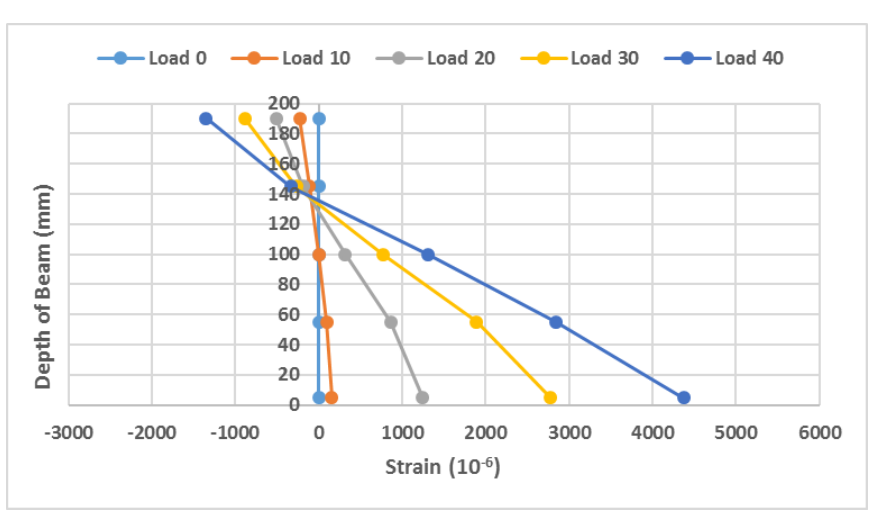
Figure 12. Depth of neutral axis for specimen